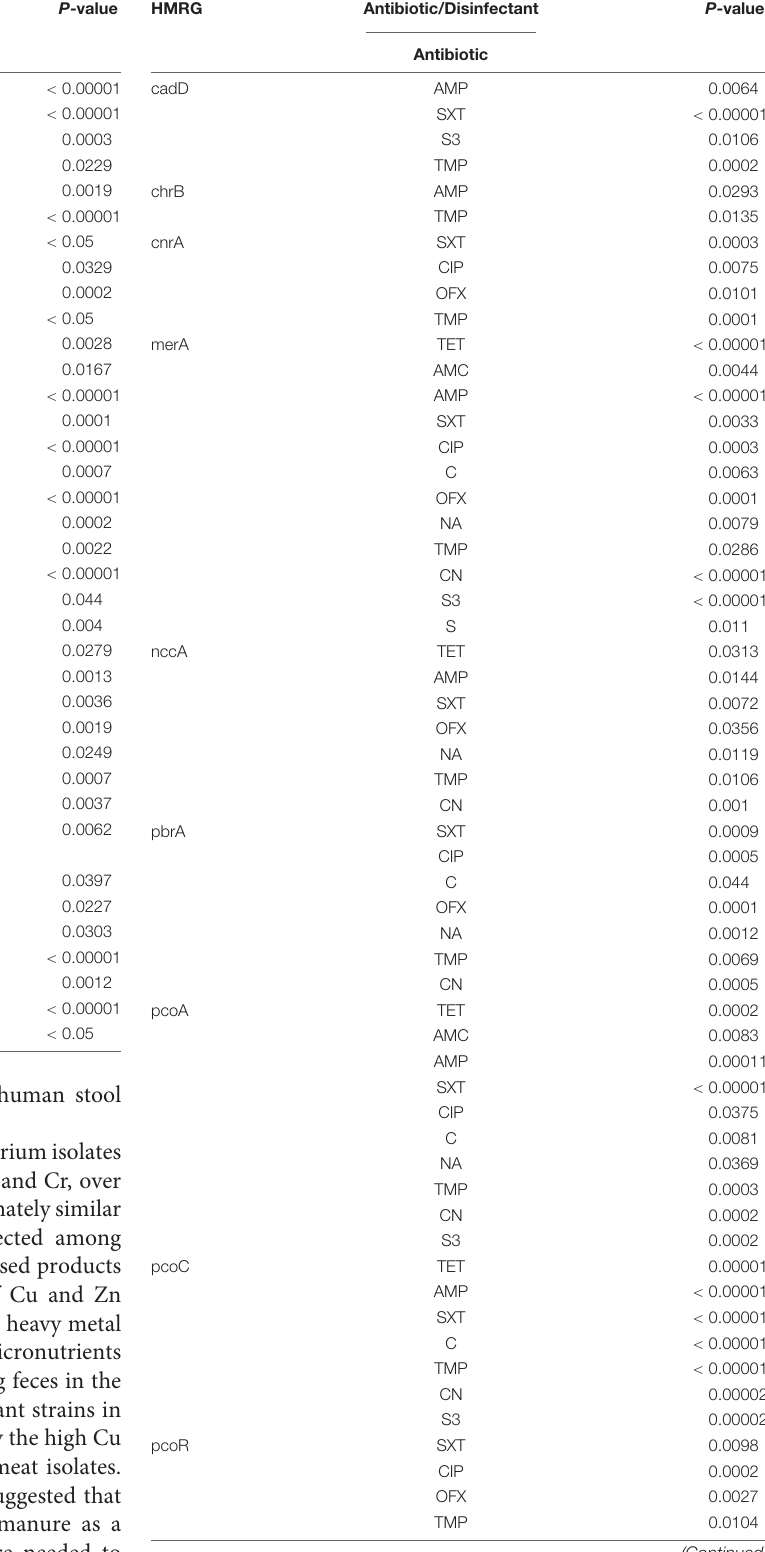
TABLE 6 | The association of HMRGs with antibiotic and disinfectant resistance in Salmonella